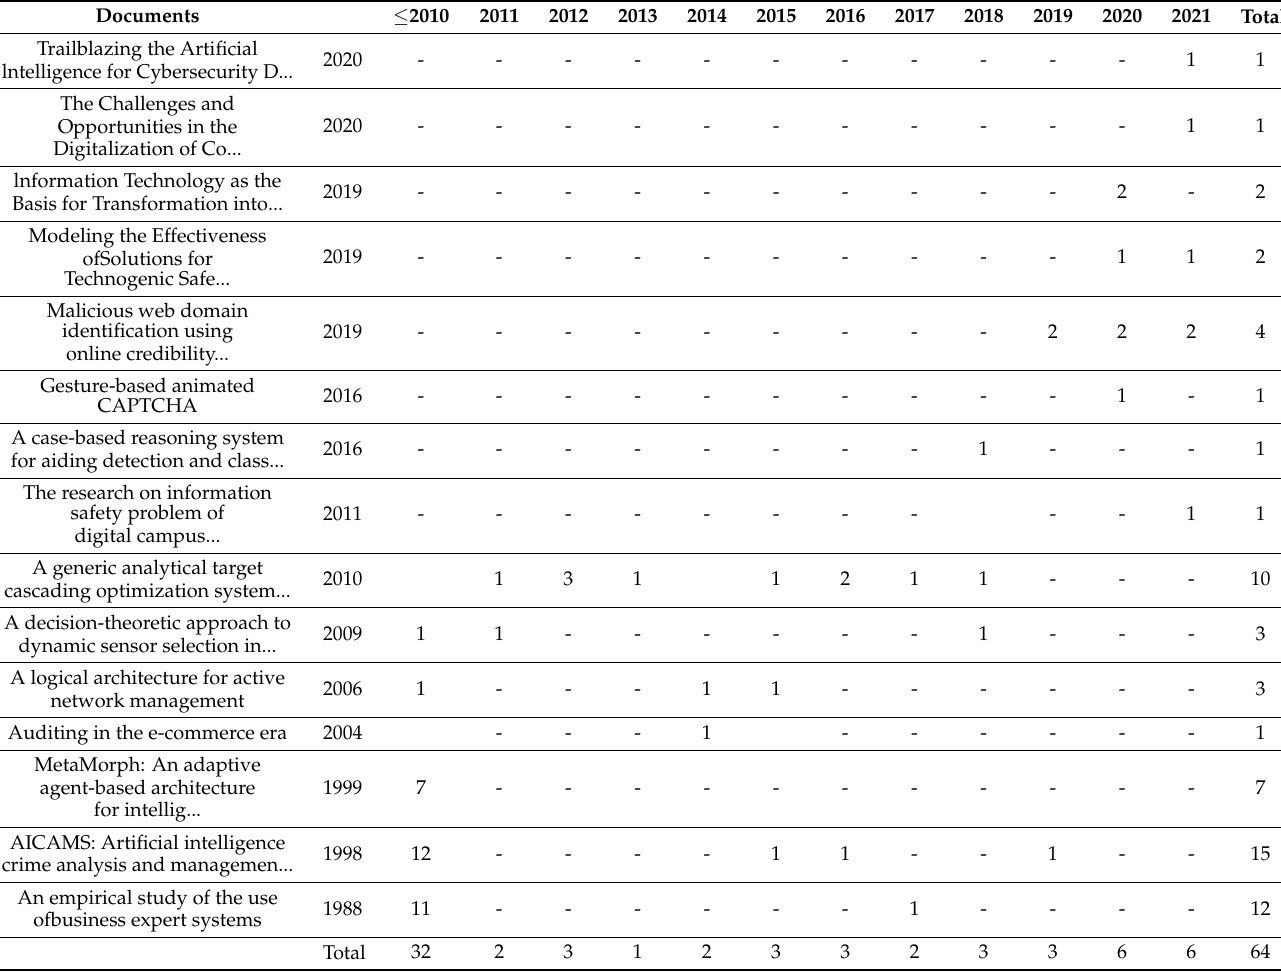
Table A2. Overview of document self-citation period ≤ 2010 to